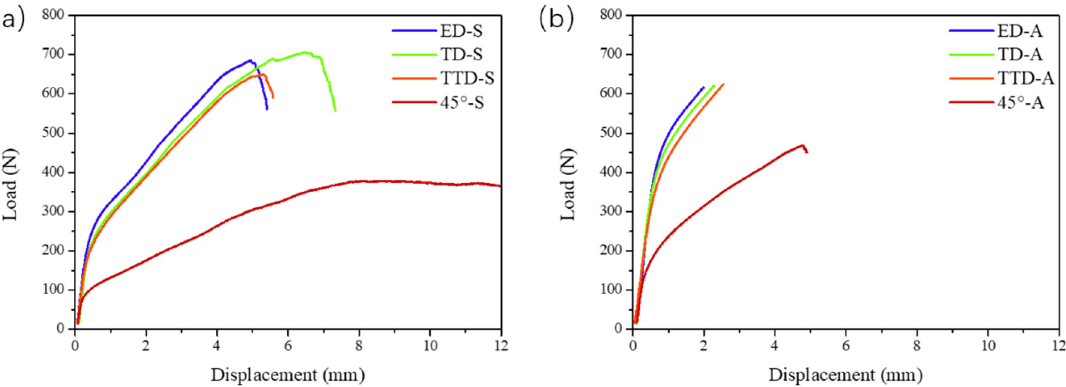
Figure 3. Mechanical response of the extruded Mg–9Al plate along four directions at ( a ) solution- treated condition; and ( b ) aged condition.